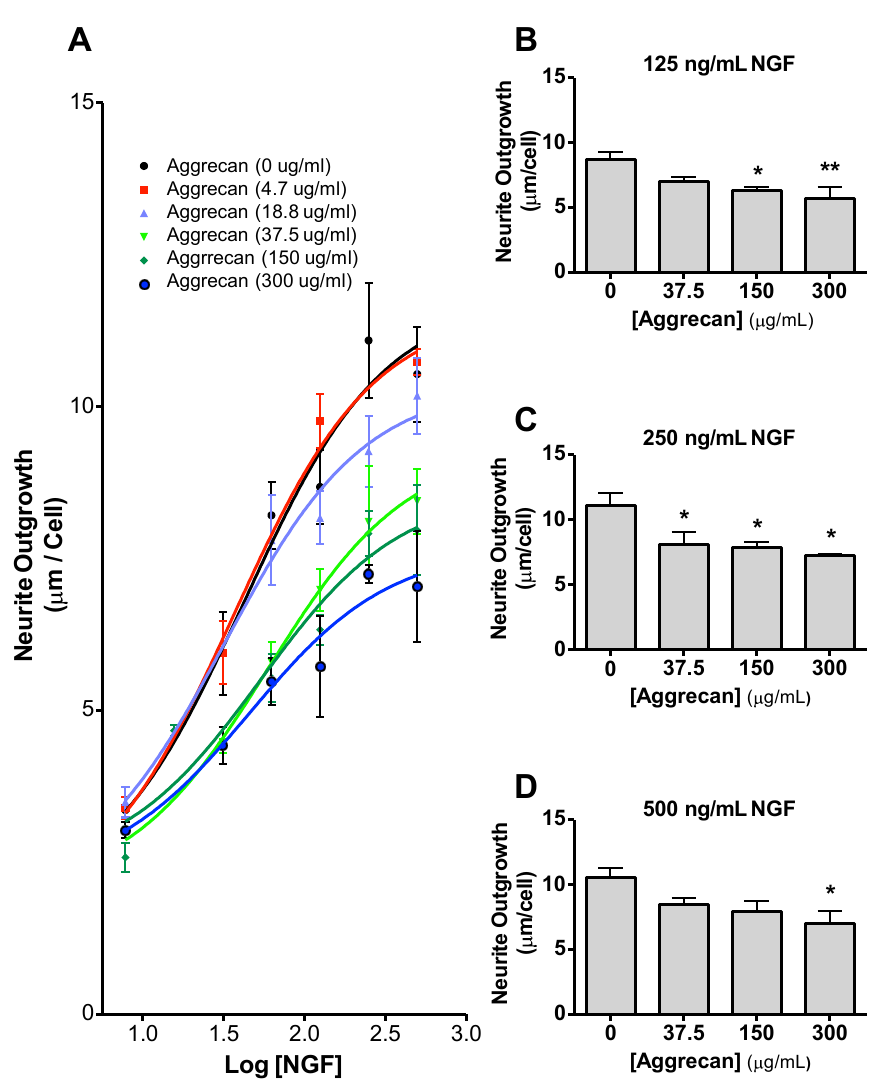
Figure 4. NS-1 neurite outgrowth is inhibited by aggrecan in a dose-dependent manner. Dose response curve for all concentrations of aggrecan analyzed ( A ). Neurite outgrowth at 125 ng/mL ( B ), 250 ng/mL ( C ) and 500 ng/mL ( D ) NGF in the presence of 0, 37.5, 150, or 300 µg.mL aggrecan. * p < 0.05, ** p < 0.01, compared to 0 µg/mL condition (Bonferonni post-hoc analysis).